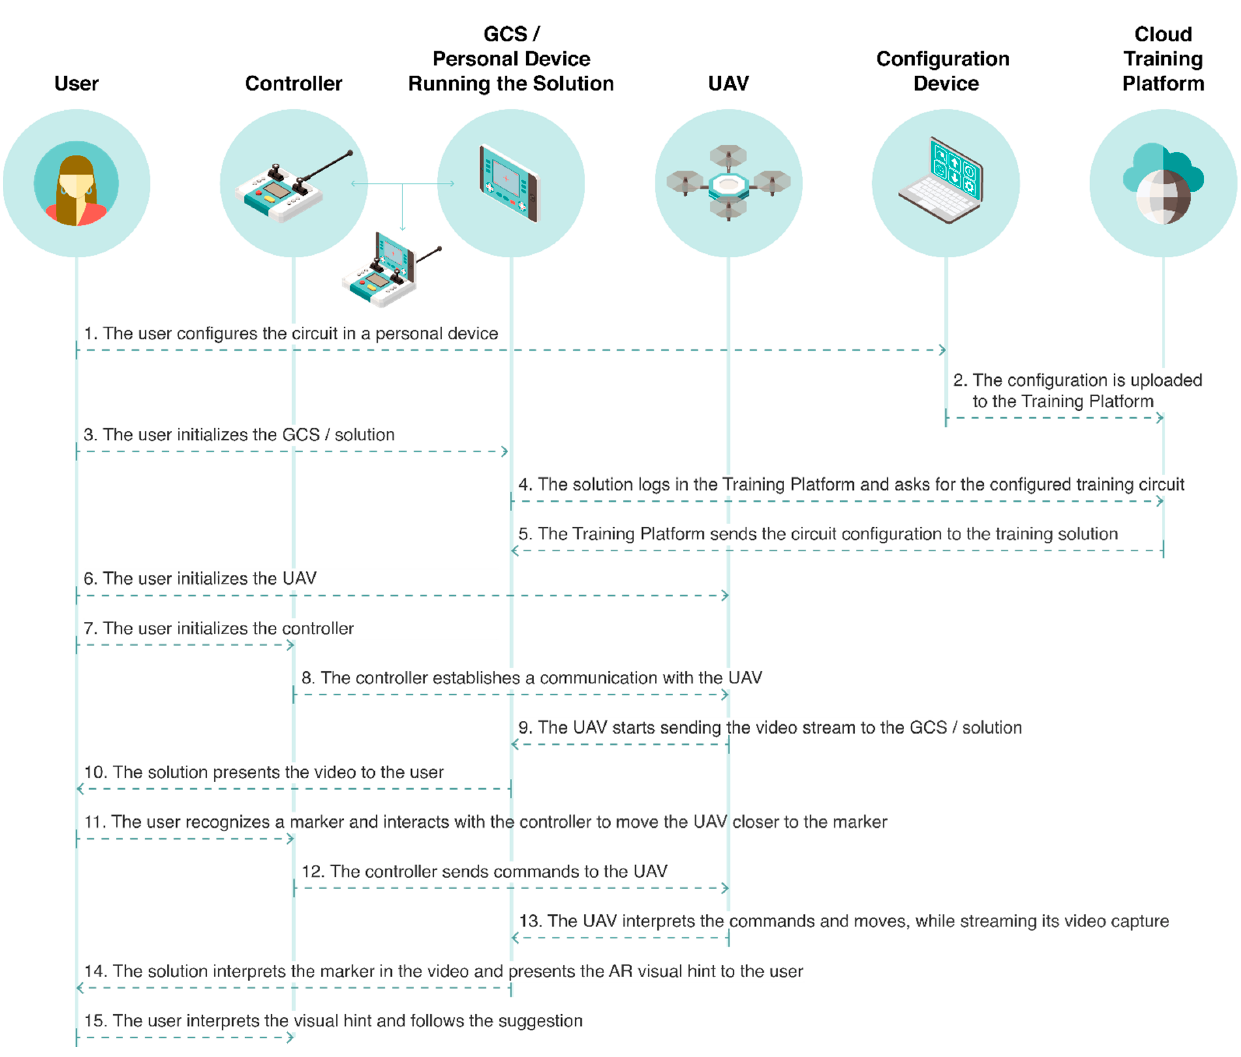
Figure 7. Architecture for the full training system for UAVs (Unmanned Aerial Vehicles), representing the integration of the solution with the control layer.